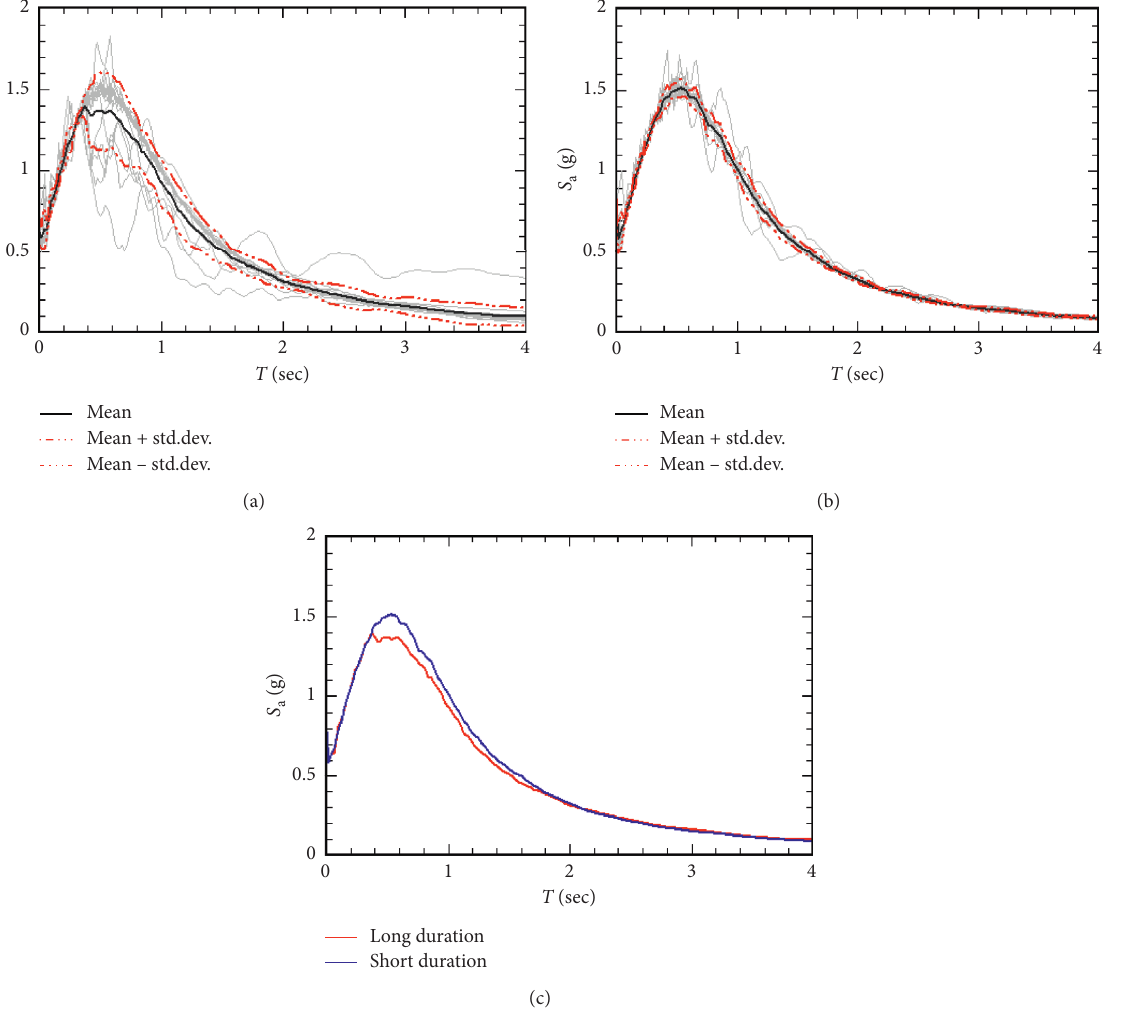
Figure 5: Geometric mean ± one standard deviation for spectra of (a) the long-duration set and (b) the spectrally equivalent short-duration set. (c) Comparison between geometric means for both ground motion sets.